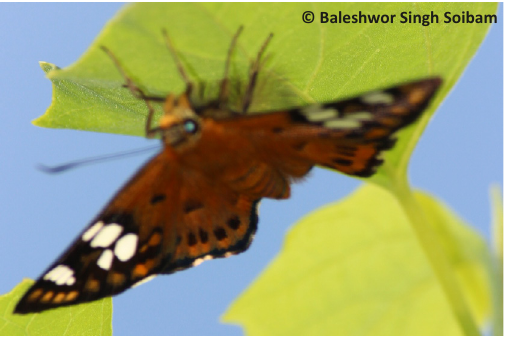
Image 3. Photographic record of Coladeina indrani uposathra Fruhstrofer, 1911 from the Heibok hills, Imphal